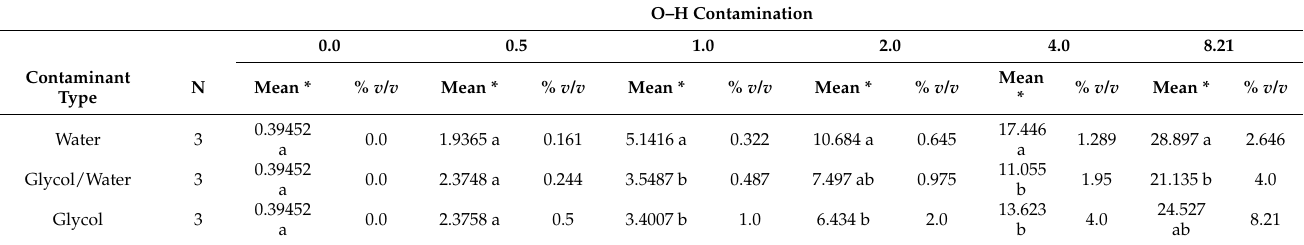
Table 4. Summary of the differences in O–H contamination rates as measured by the mean absorbance in the area of the 3150–3500 wavenumber range. The % v/v equivalents for each contaminant type are shown for the corresponding O–H contamination